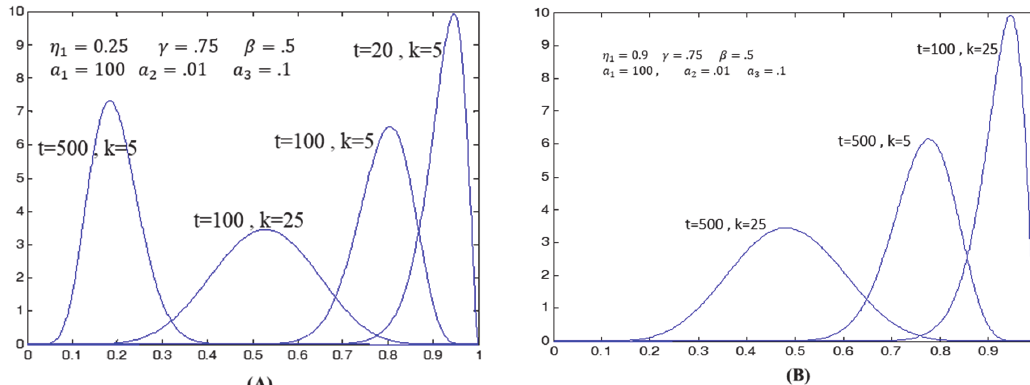
Fig. 7 . various probability distributions for the erosion variable given the elapsed lifetime and the number of incomplete maintenance operations (A and